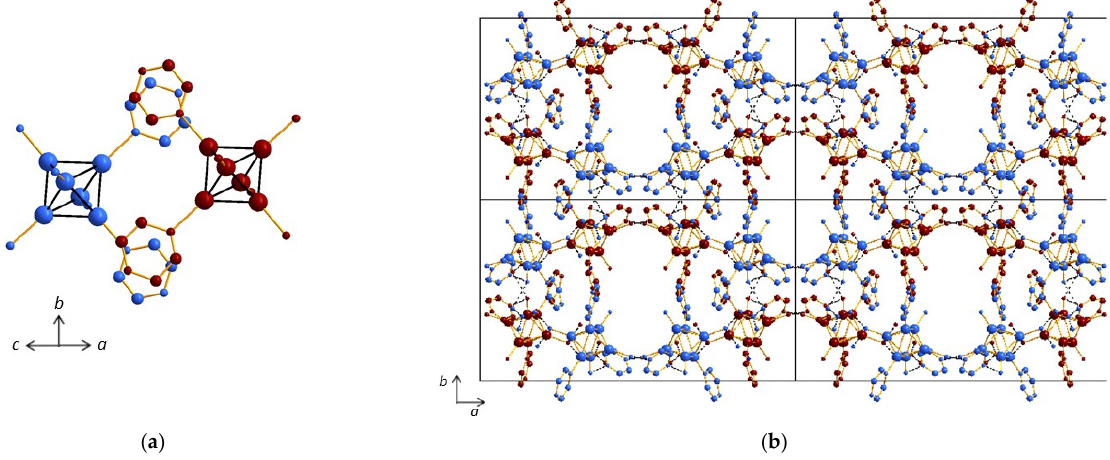
Figure 6. ( a ) π – π stacking involving coordinated generating cluster dimers in the structure of ( 3 ). ( b ) Stacking of the sheets along the c axis in the structure of ( 3 ). Crystallization water molecules are not depicted for clarity.